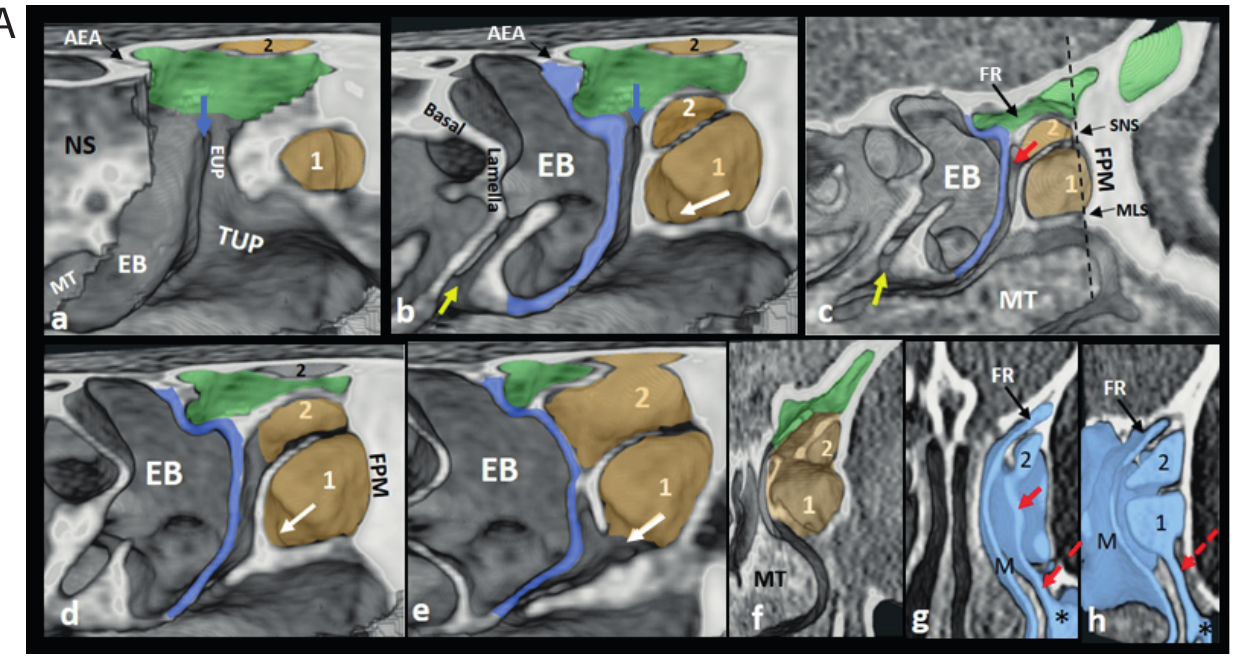
Figure 2. IS-EUP pneumatizes into the Frontal Recess. A. Two chambered IS-EUP expands into Frontal Recess. a.-e. 3D slight medial obliqued sagittal images (left side, sequentially from medial to lateral) status/post an irregular virtual resection of the anterior middle turbinate reveals the FSRS (light green), and the IS-EUP includes two compartments (gold outline, 1,2). Note the communication of the FSRS with the Hiatus Semilunaris (blue arrows). The superior IS-EUP compartment (2) extends supero-laterally to fuse with the LP, and narrowing the medial FR space, and has an individual drainage into the EI (red arrow). The inferior IS-EUP compartment (1) drains infero-posteriorly into the TI (white arrows). Note the oblique vertical dashed line in Fig. c, a plane adhering to the SNS superiorly, and the Maxillo-Lacrimal Suture inferiorly, a proposed plane of virtual separation between the FS and FR. TUP: Turbinal Uncinate Process; yellow arrow: Retro Bullar Recess Space. f. 3D obliqued coronal view from anteriorly reveals the FSRS (green outline), and its relationship with the two compartments in the IS-EUP (gold out- line, 1,2), enclosed within the bony outline of the EUP. MT: Middle Turbinate. g., h. 3D obliqued coronal images viewed from anteriorly, show the 3D air outline within the Frontal Recess (FR), and its communication with the Middle Meatus (M), and that compartment #1 drains into the EI (red arrow) and subsequently into the TI and maxillary sinus (black asterisk). The infe- rior compartment #2 drains into the TI (dashed red arrow), and into the Maxillary Sinus. Larger red arrow: points to the TI which inferiorly then communicates with the maxillary sinus (hidden in these images).